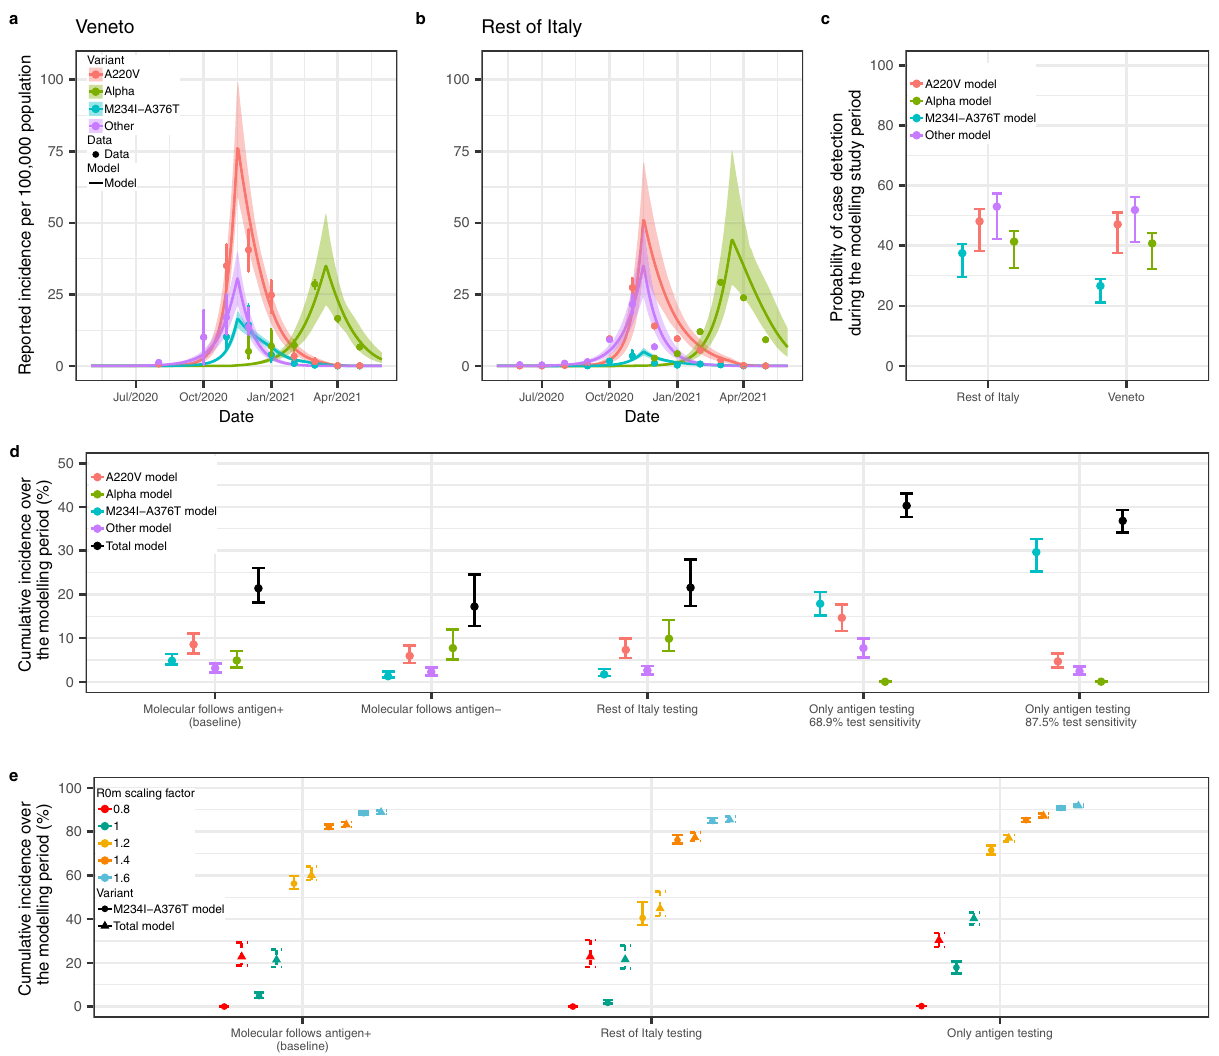
Fig. 5 | Transmission dynamics of SARS-CoV-2 variants (A220V, M234I-A376T, Alpha and others) in Veneto and the rest of Italy, and cumulative incidences underdifferentcounterfactualtestingscenarios.a Venetoand b therestofItaly estimated daily reported incidences per 100,000 population of A220V, M234I- A376T, Alpha and other virus variants, fi tted from observed incidence data assumingaNegativeBinomiallikelihood(pointand95%binomialCI).Estimatesare the mean and 95% CrI (solid line and shaded region), obtained from the 2.5% and 97.5% percentiles of 100 samples of the posterior distributions. c Probability of detecting cases attributable to the A220V, M234I-A376T, Alpha or other virus var- iants in Veneto and the rest of Italy during the modelling study period. Point and errorbarsarethemeanand95%CrIobtainedfromthe2.5%and97.5%percentilesof 100 samples of the posterior distributions. d Cumulative A220V, M234I-A376T, Alpha, other virus variants and total incidence (%) in Veneto during the